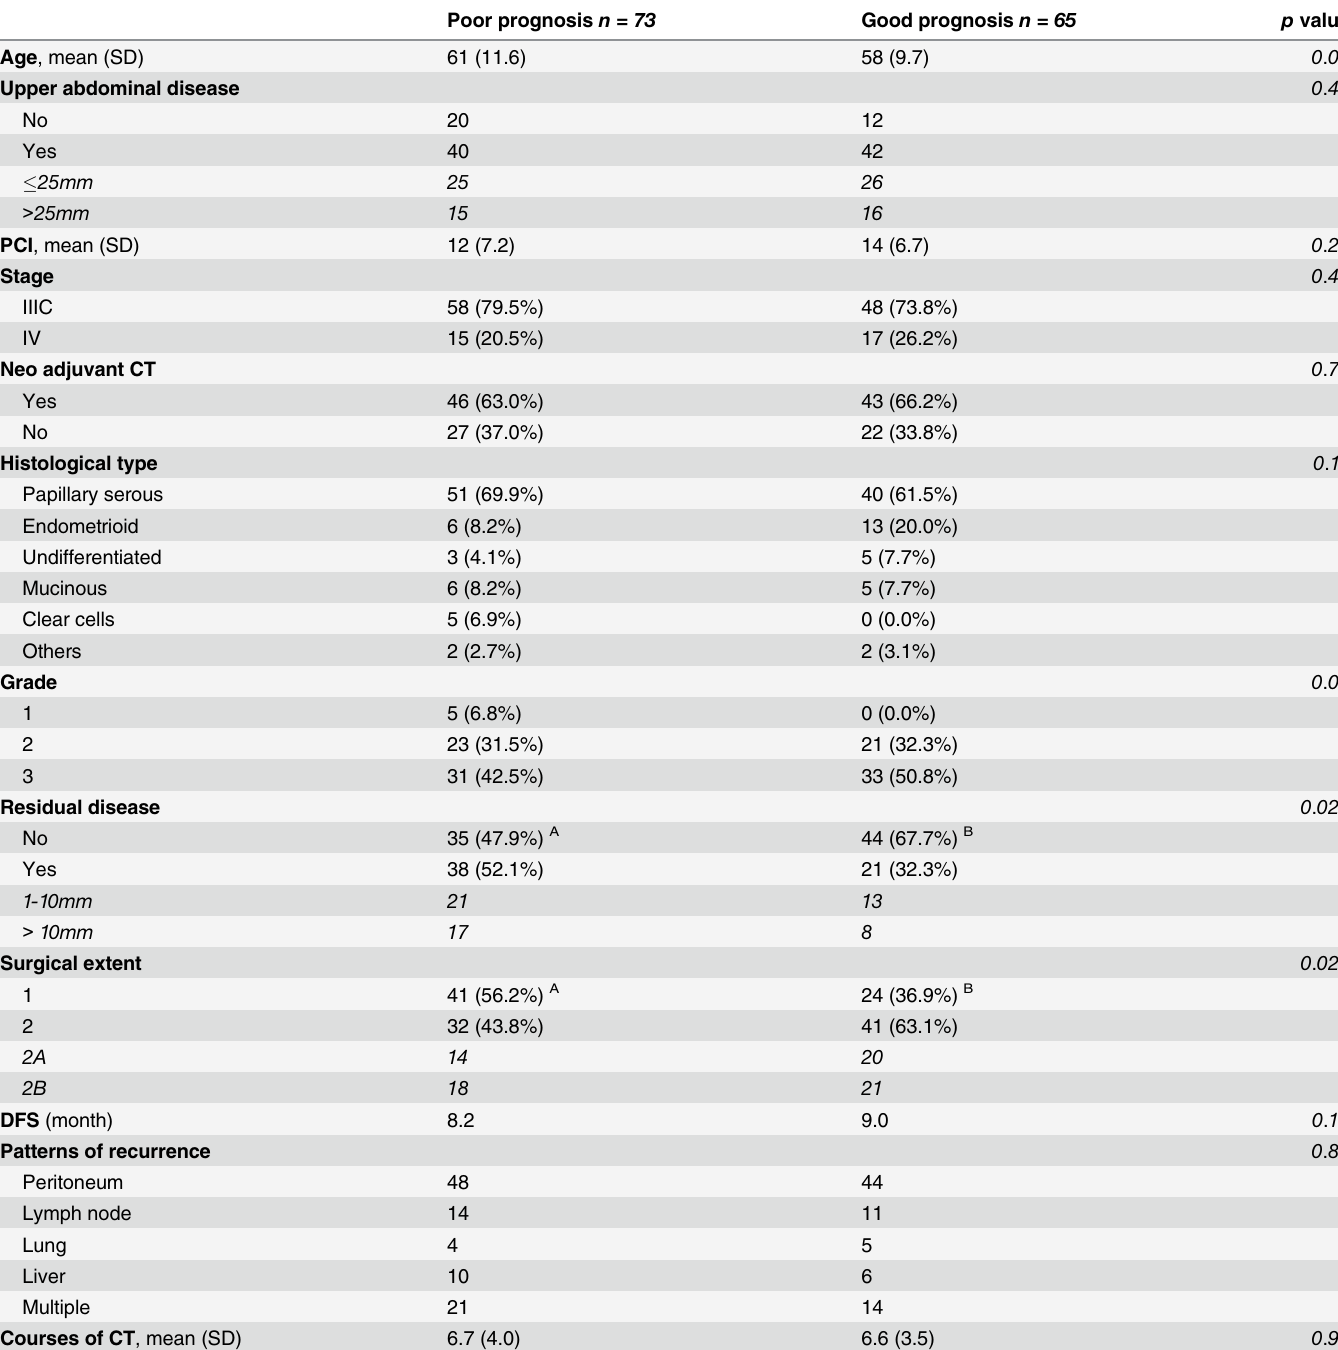
Table 4. Comparative characteristics between poor prognosis and good prognosis Early Relapse